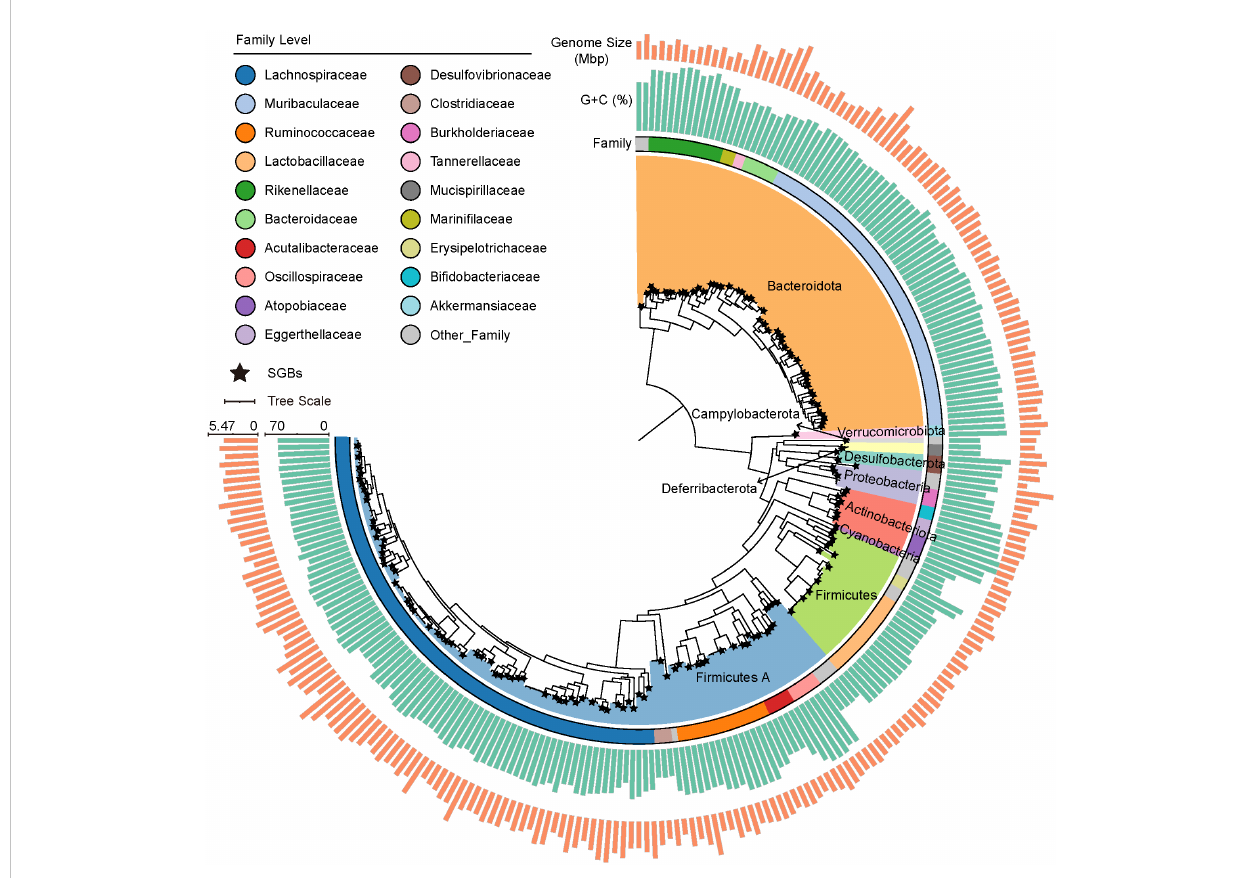
FIGURE 1 Phylogenetic tree of 241 metagenome-assembly genomes (MAGs) from the cecal contents of mice, with color fi lling on branches representing phylum-level classi fi cation. The stars mark the caudal end of the branches, indicating species-level genome bins (SGBs). The three rings from inside to outside represent family-level classi fi cation, GC content, and genome size of each MAG,